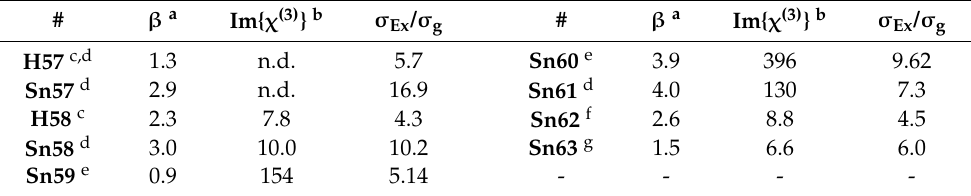
Table 7. β, Im{χ (3) } and the ratio σ Ex /σ g for some phthalocyanines.